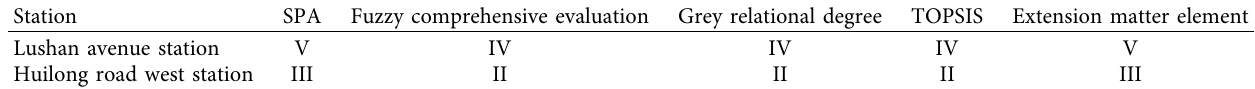
Table 12: Evaluation results of different evaluation methods.